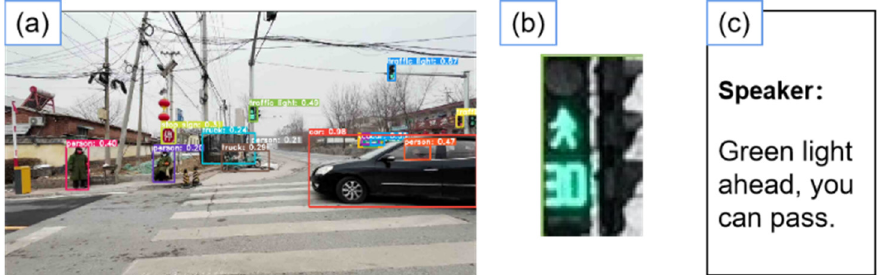
Figure 17. Traffic light detection processing and results. ( a ) Object detection processing results. ( b ) Traffic light image cropping results. ( c ) Report statement.